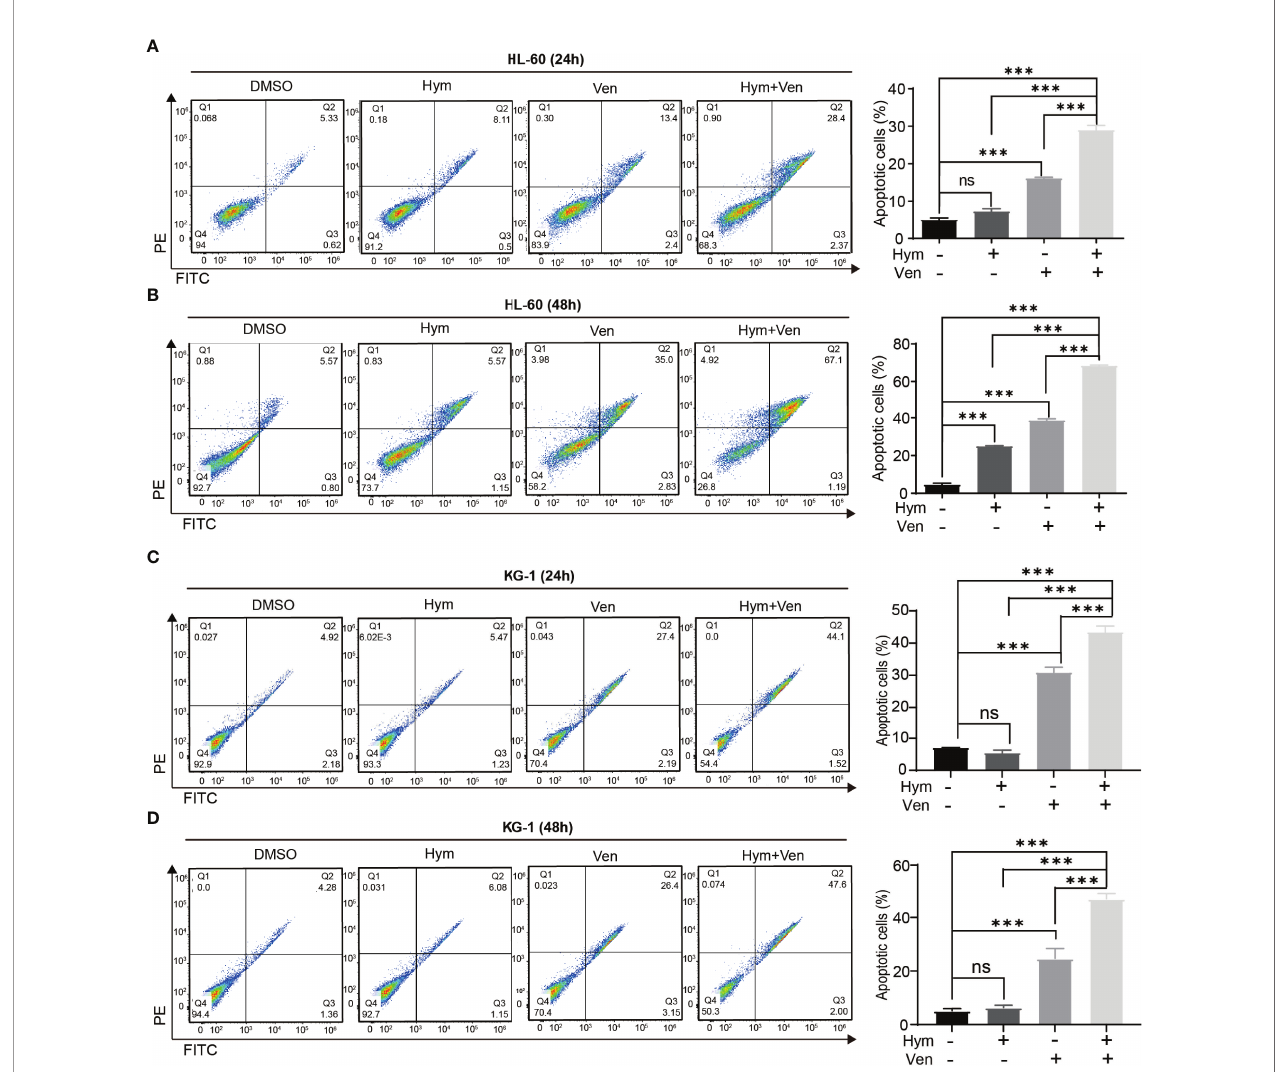
FIGURE 5 | Combined treatment with venetoclax and hymeglusin promotes the apoptosis of AML cells. (A, B) The percentage of apoptotic cells after venetoclax (0.1 m M) and hymeglusin (16 m M) treatment for 24 (A) to 48 h (B) in HL-60 cells. The left panel shows the fl ow cytometry scatter plot. (C, D) The percentage of apoptotic cells after venetoclax (10 m M), hymeglusin (16 m M) or both treatment for 24 (C) to 48 h (D) in KG-1 cells. The fl ow cytometry scatter plots were shown the left part. ***P<0.001. ns, not signi fi